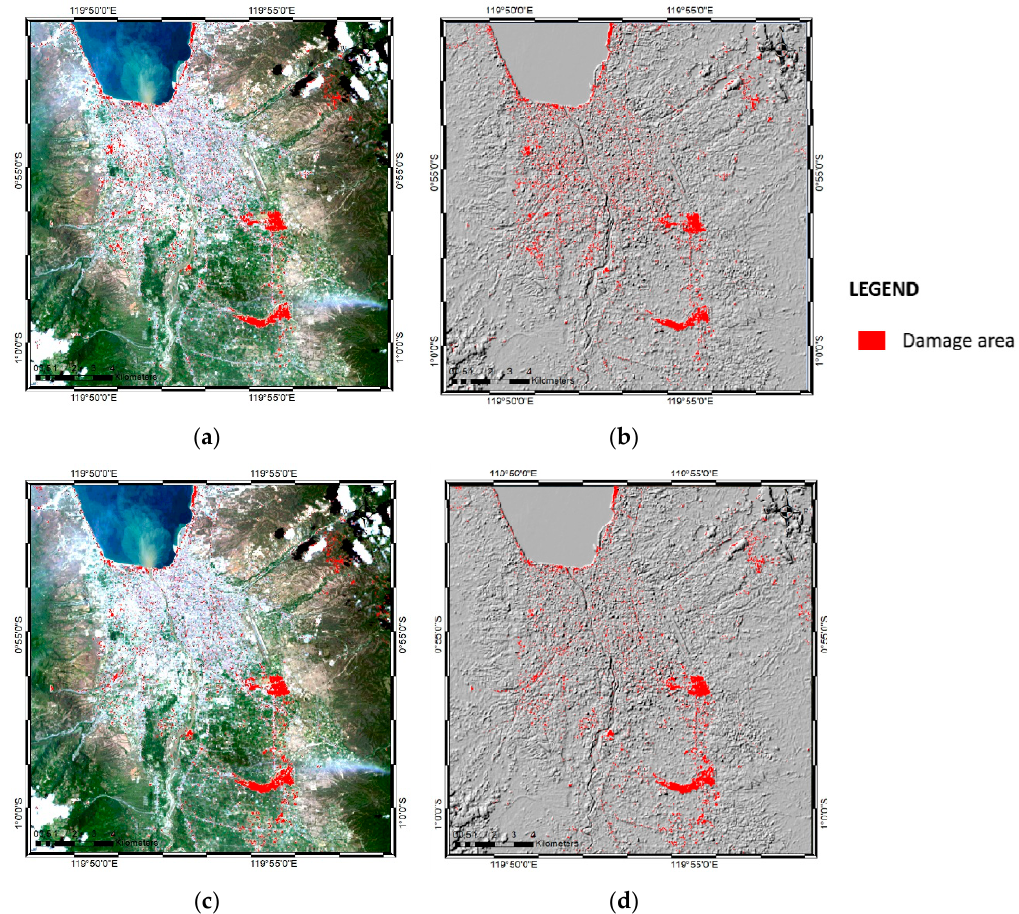
Figure 9. Post-earthquake damage maps of Palu, Indonesia, generated using the decorrelation method from the ( a ) ANN classification results in true color view, ( b ) ANN classification results in hillshade view, ( c ) SVM classification results in true color view, and ( d ) SVM classification results in hillshade view.